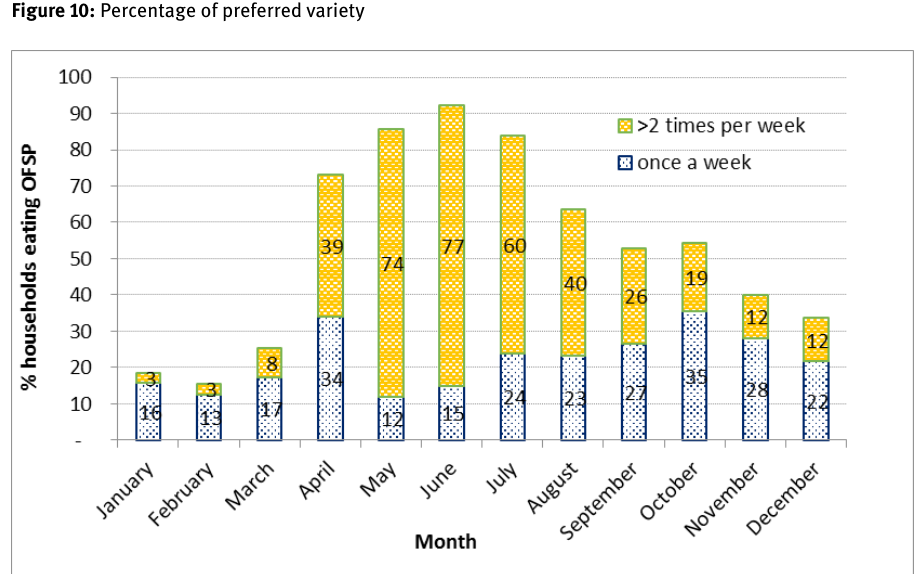
Figure 11: OFSP Consumption